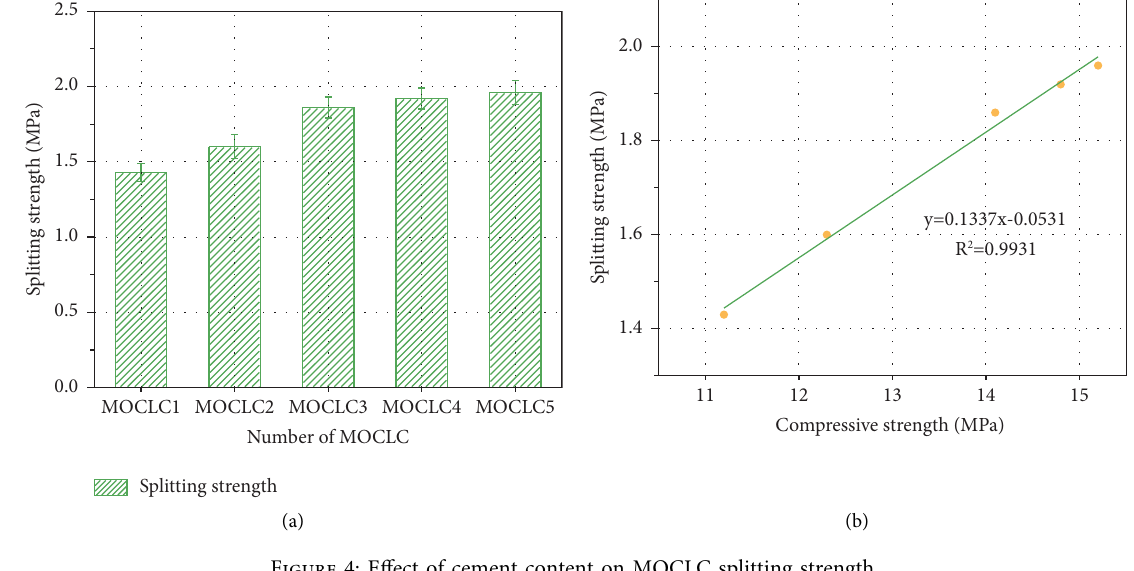
Figure 4: Efect of cement content on MOCLC splitting strength.